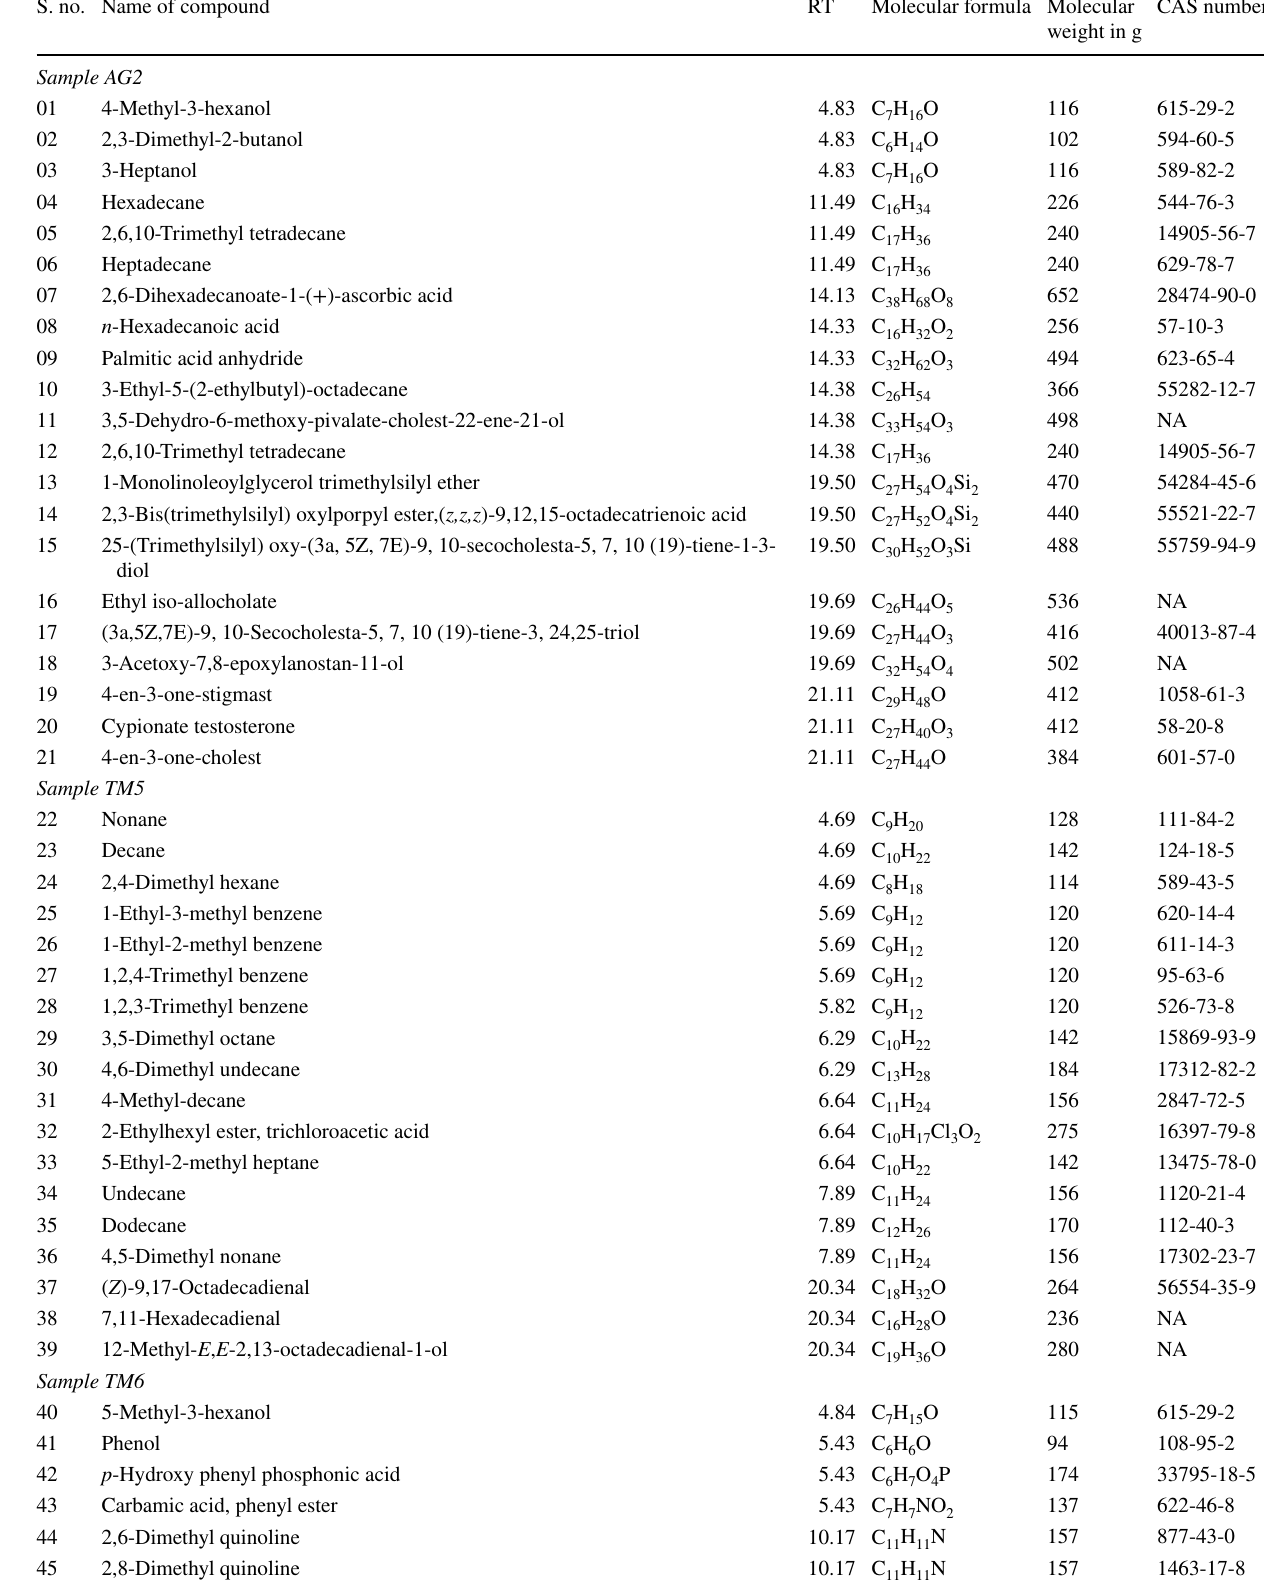
Table 3 Probable organic compounds detected from collected effluent samples AG2, TM5 and TM6 by GC–MS technique S. no. Name of compound RT Molecular formula Molecular